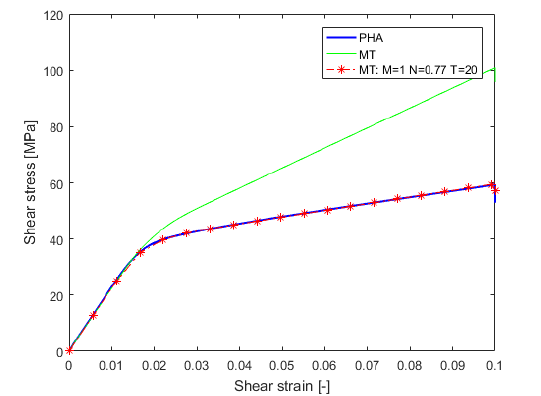
Figure 12. Comparison of FEM and MT predictions with ω given by Eq.